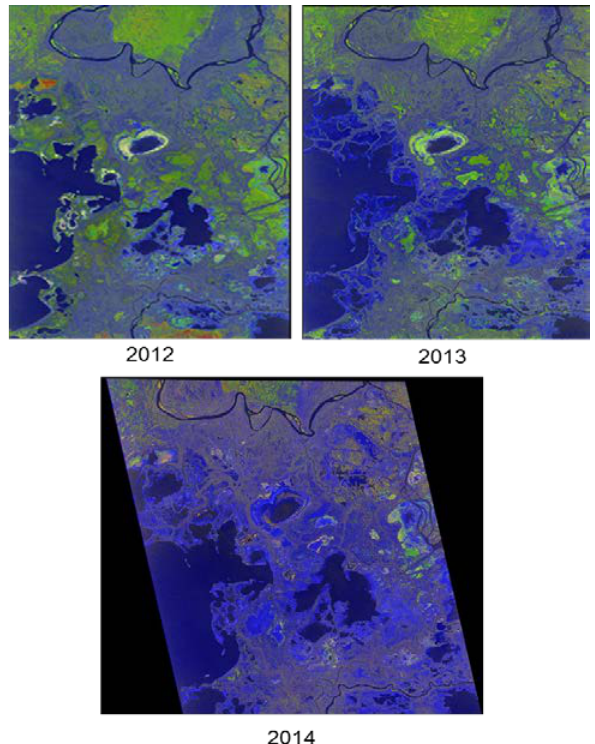
Figure 5. Example coherence product of the PAD for 2012 to 2014.